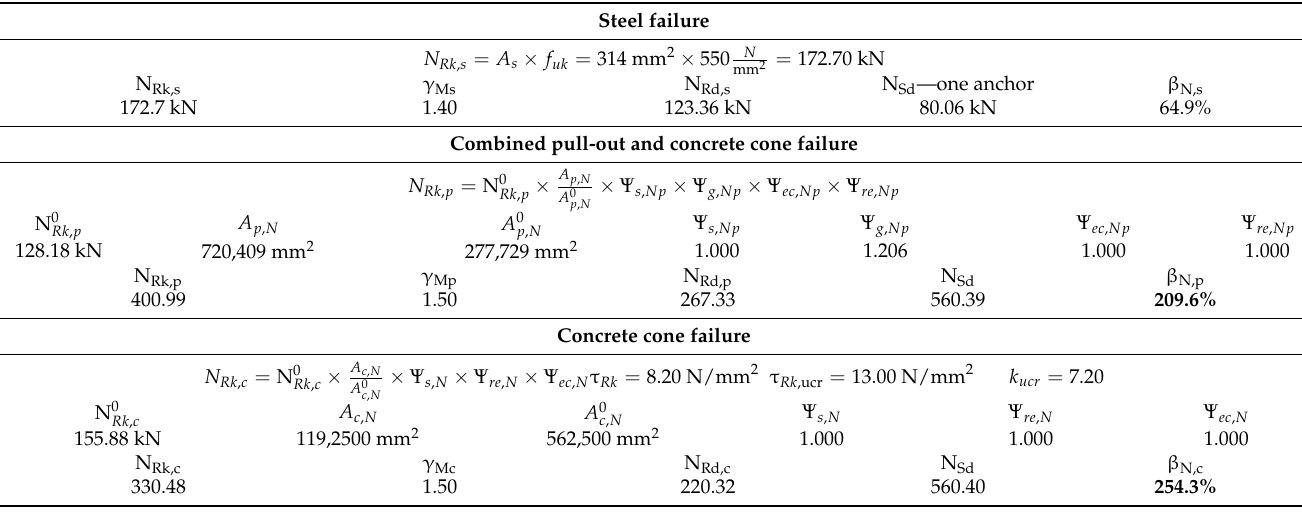
Table 2. Results of calculations of load-bearing capacity of the rebars in the foundation slab without consideration of shearing [18].